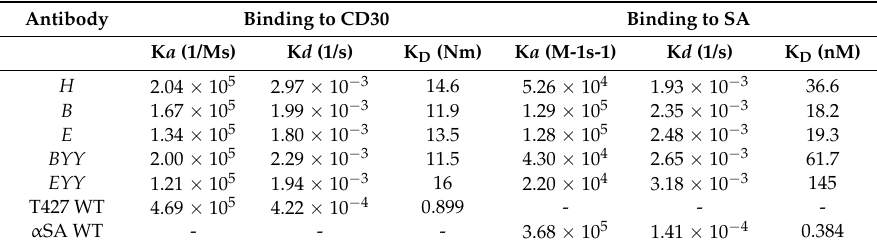
Table 5. Binding kinetics of the bsAbs and their parental mAbs to CD30 and SA antigens, as determined by SPR. Surface plasmon resonance binding affinities collected from a Biacore T200, of the investigated bsAbs and their parental antibodies to CD30 and